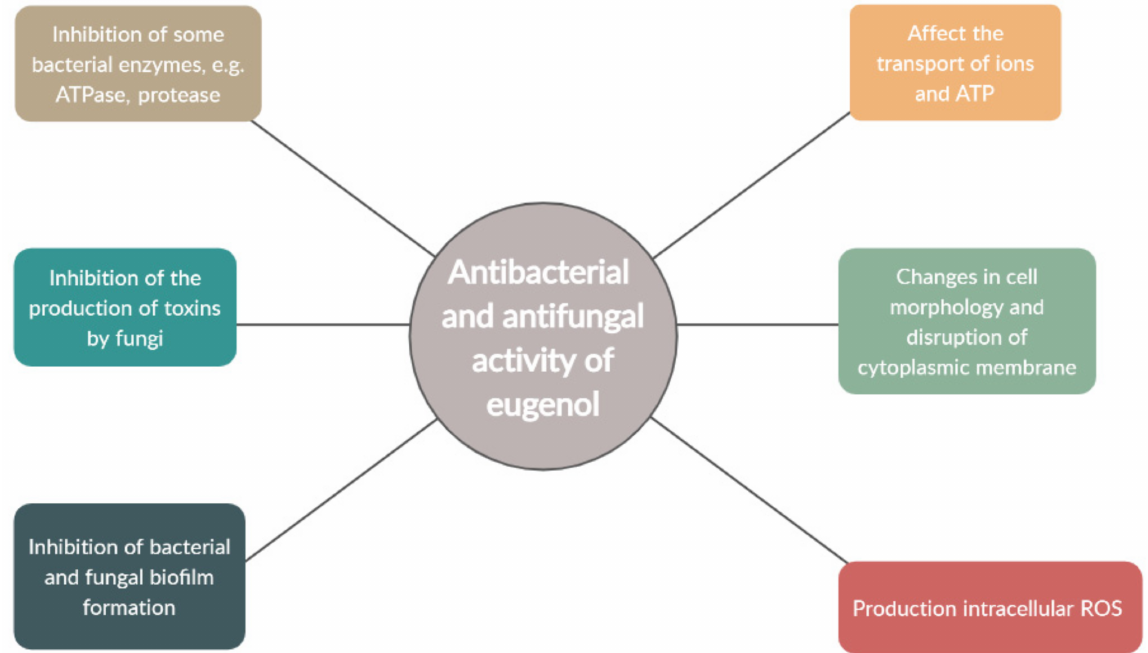
Figure 2. Antibacterial and antifungal activity of eugenol (own elaboration based on [2,9,20]). Sharifzadeh and Shokri [22] investigated the antifungal potential of eugenol using the broth microdilution test and the likely synergistic effect of eugenol with voriconazole in vitro against Candida strains isolated from mares’ reproductive tract using the checker- board microdilution method. Eugenol MIC values for eugenol were 400–800 µ g/mL for Candida tropicalis and 200–400 µ g/mL for Candida krusei . Synergistic effects of eugenol and voriconazole were observed for Candida tropicalis (83.3%) and Candida krusei (77.7%), and no antagonistic activity occurred. Consequently, eugenol is a potential antifungal agent designed to fight the genital Candida yeast. Moreover, the combination therapy of eugenol and voriconazole may prove effective in antimicrobial resistance in mares with genital